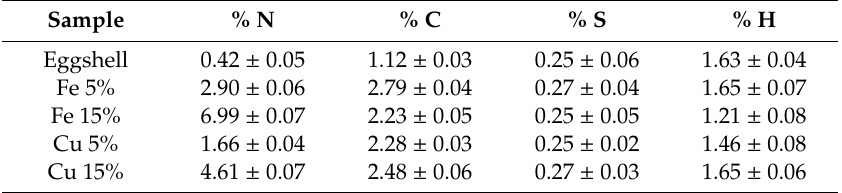
Table 1. Elemental analysis of the calcined eggshell and the iron and copper supported nanomaterials.